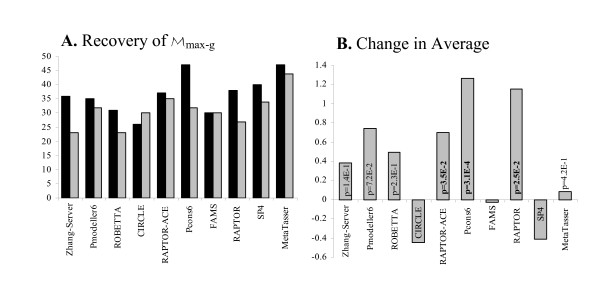
Reranking models from top servers. Each server predictor submitted five models per target, with the highest confidence model ranked first. (A) the number of targets where each server's highest GDT-TS model is ranked first is shown with gray bars, and black bars when the models are reranked with SELECTpro. (B) shows the change in average GDT-TS for each group when SELECTpro is used to select model 1. P-values of paired t-tests are shown above the horizontal axis when SELECTpro demonstrates improved model selection and statistically significant improvements (p < .05) are in bold.